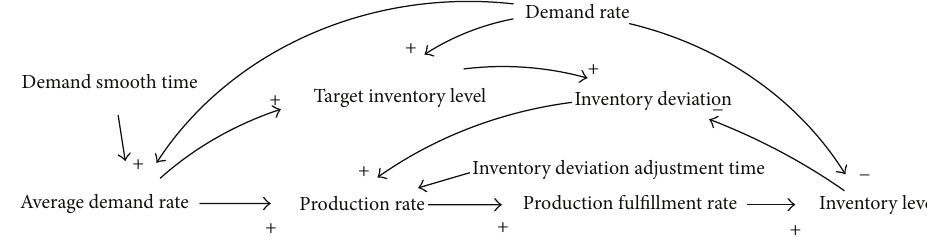
Figure 2: IOBPCS model causal